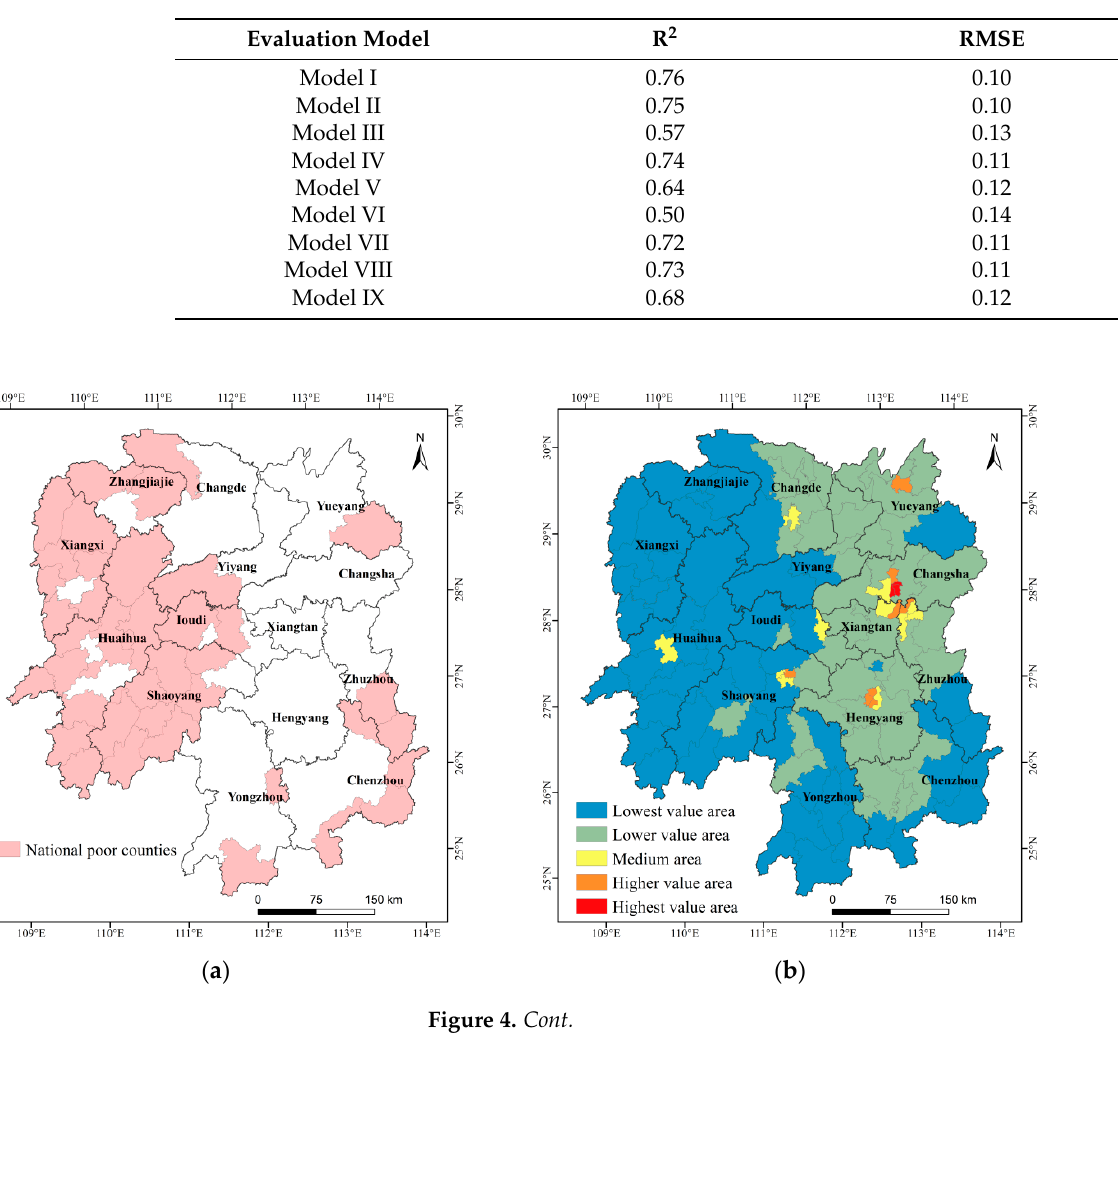
Table 5. Results of the evaluation models of localized SDG 1 indicators in Hunan Province.